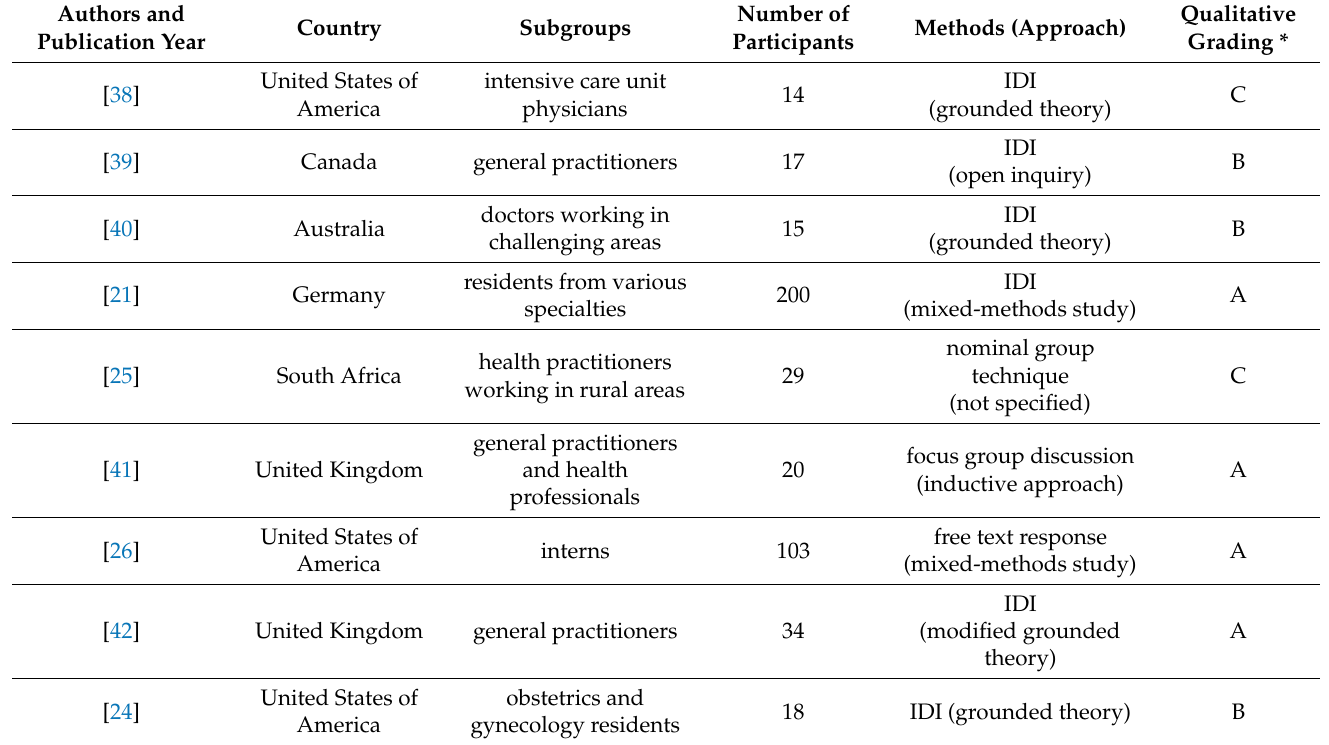
Table 2. Summary of studies included in the